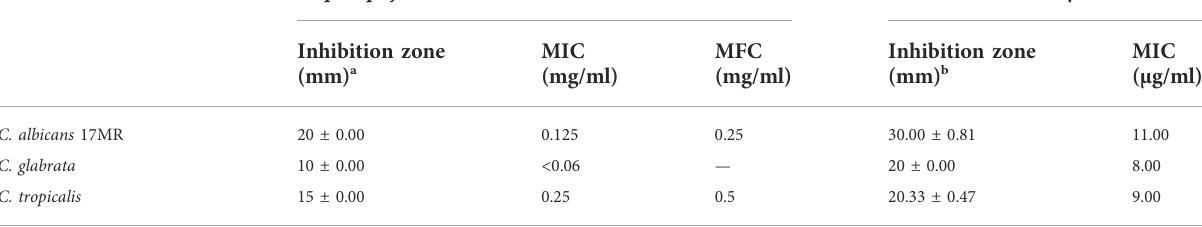
TABLE 2 Anti- Candida and antibacterial activities of the essential oil of A. porophyllum var. cancellatum . Yeast strain